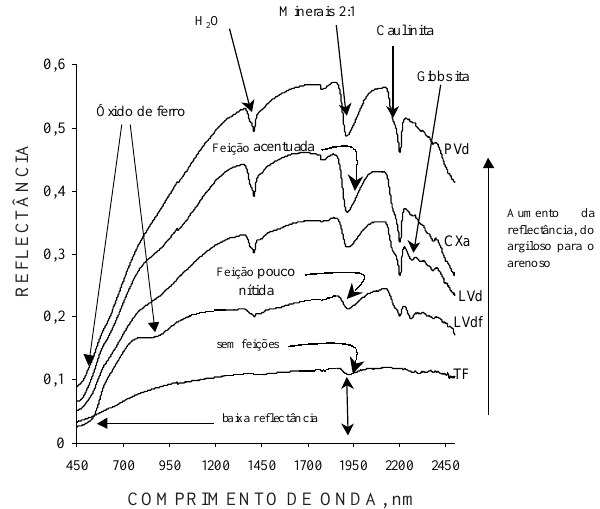
Figura 2. Curvas espectrais médias dos solos comparados à curva espectral da torta de filtro (TF). As curvas foram obtidas antes da incubação com